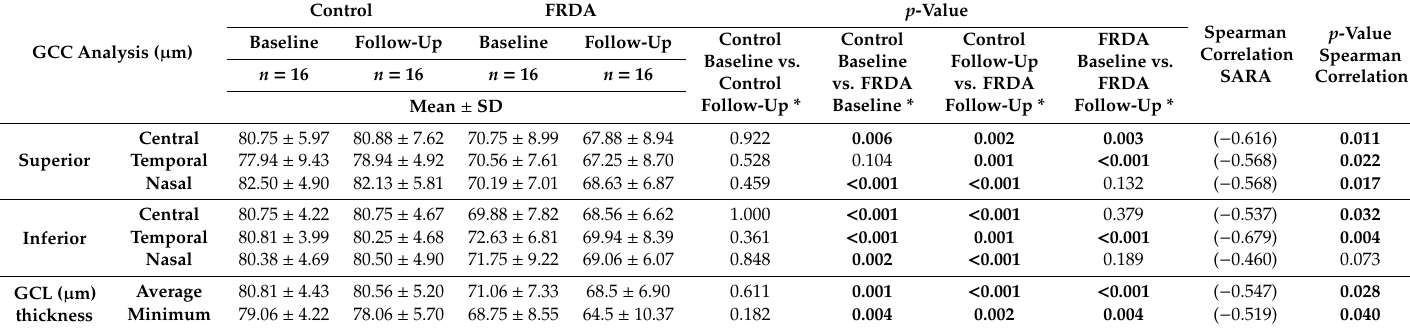
Table 3. Analysis of ganglion cell complex measures by OCT between FRDA and control